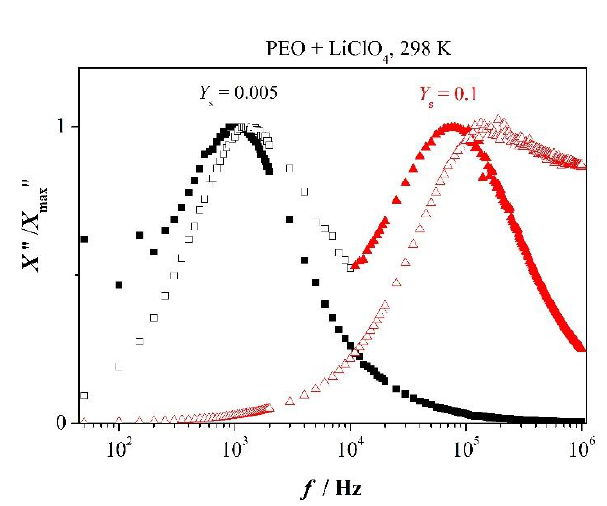
Figure 4. Scaled imaginary parts of impedance Z* and electric modulus M* ; scaled Z ”—solid marker, scaled M ”—open marker.